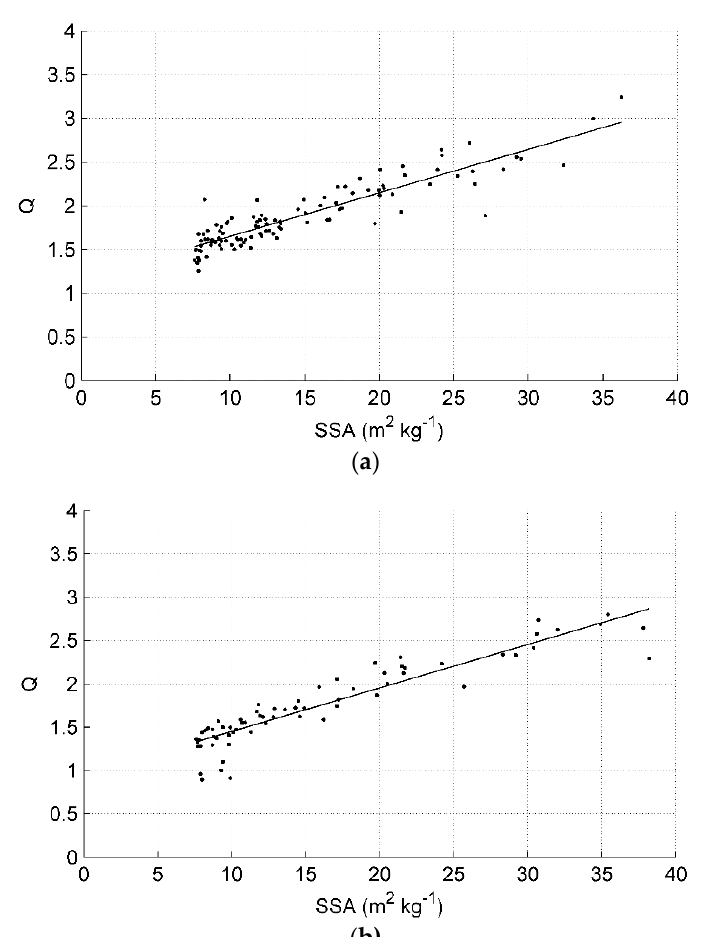
Figure 7. Scatter plot of Q with Equation (2) ( y -axis) and SSA ( x -axis) from the QST measurements made ( a ) directly from the snowpack profile and ( b ) the measurements from the sampled snow. Lines fitted to the points are marked.